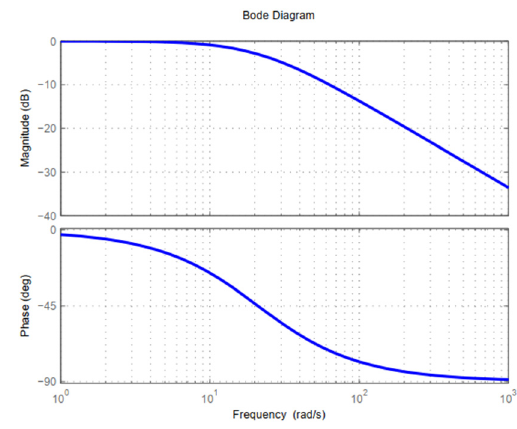
  F s L , where 1     F s F s L L , where 1 , where 1